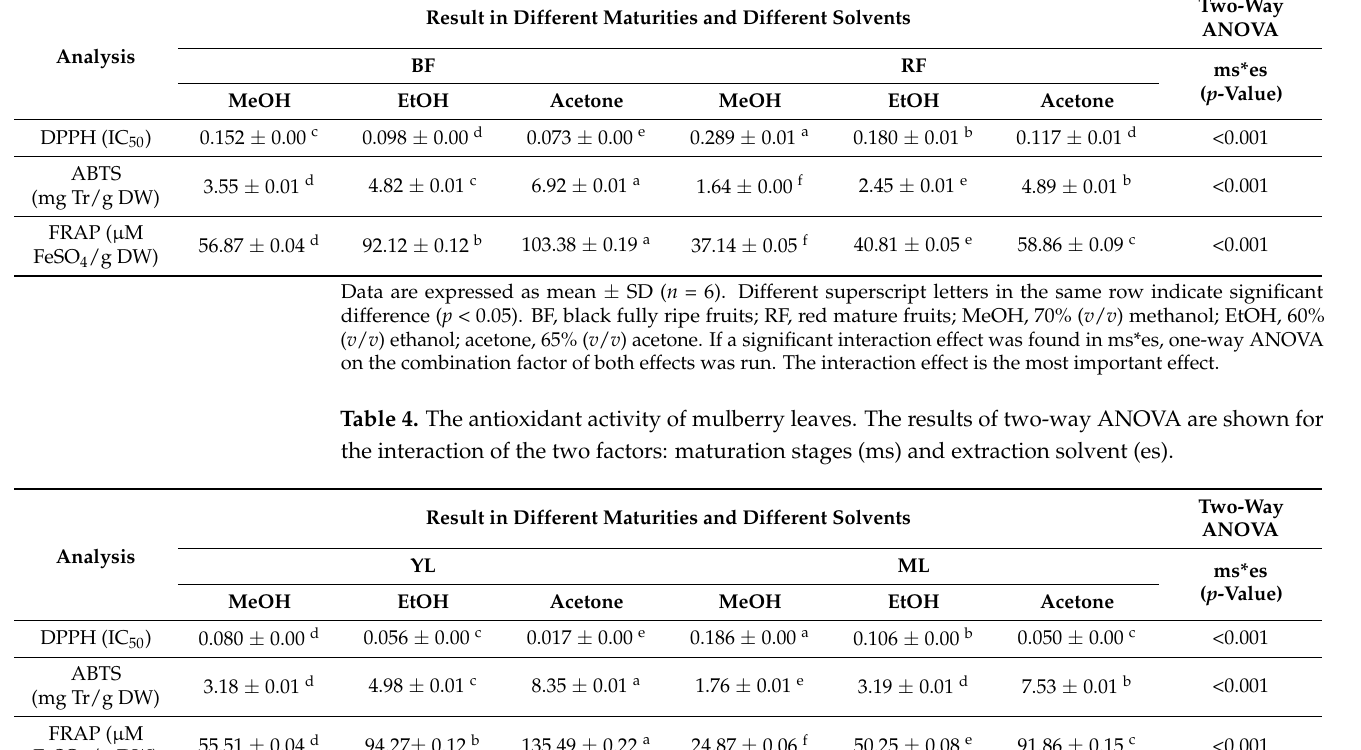
Table 3. The antioxidant activity of mulberry fruits. The results of two-way ANOVA are shown for the interaction of the two factors: maturation stages (ms) and extraction solvent (es).